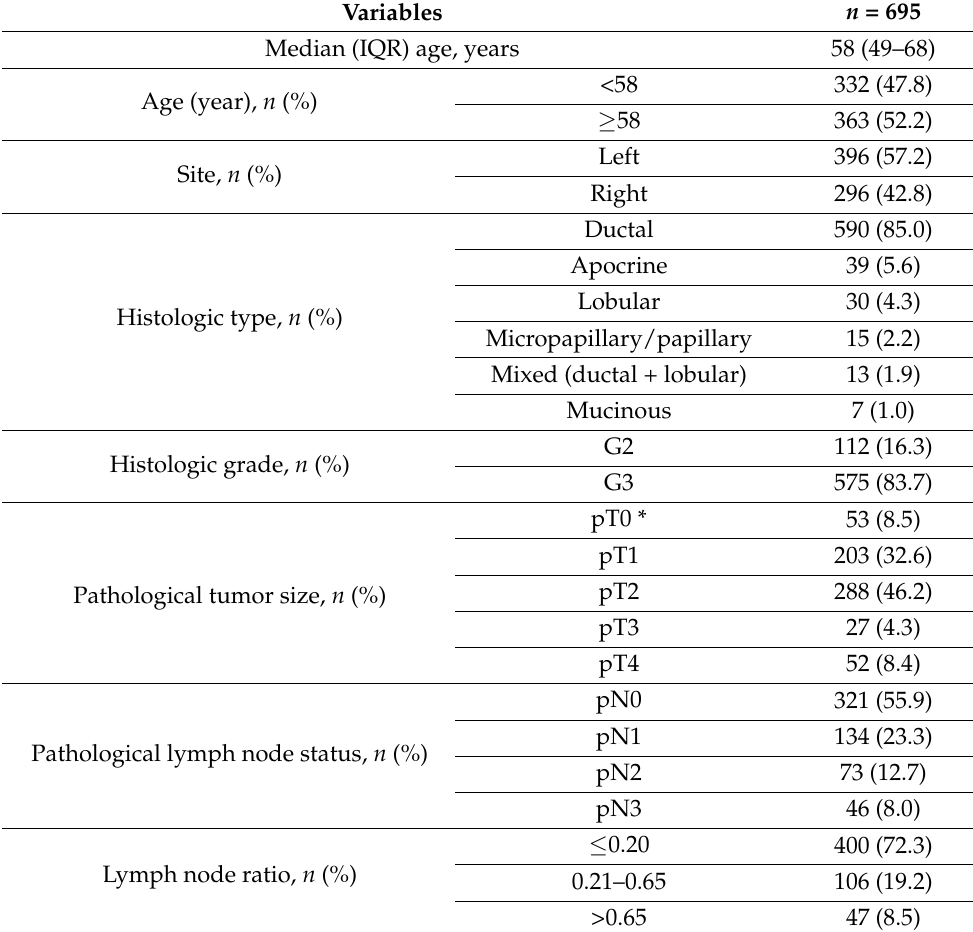
Table 2. Clinico-pathological features of HER2-positive breast